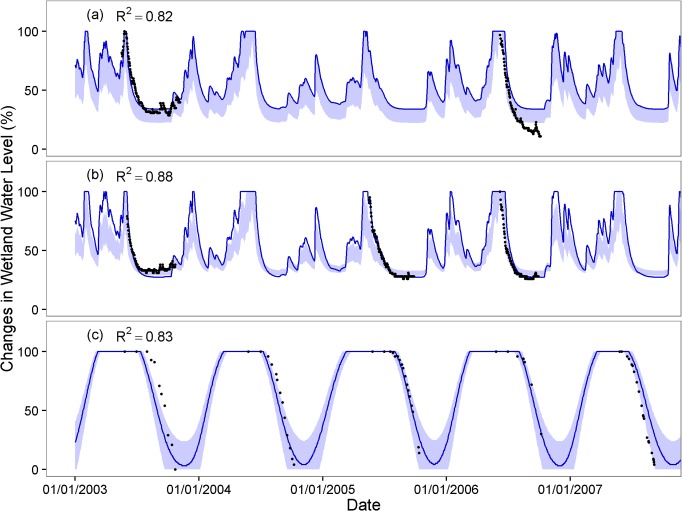
Observed wetland water levels compared with simulation using the regression models for a) Deschutes National Forest, OR, b) Willamette National Forest, OR, and c) Trinity Alps Wilderness, CA.Dark blue lines are produced by the regression equation deriving from the best fit from all available years. Blue bands show the range of uncertainty associated with alternate regression parameters deriving from other years of data.